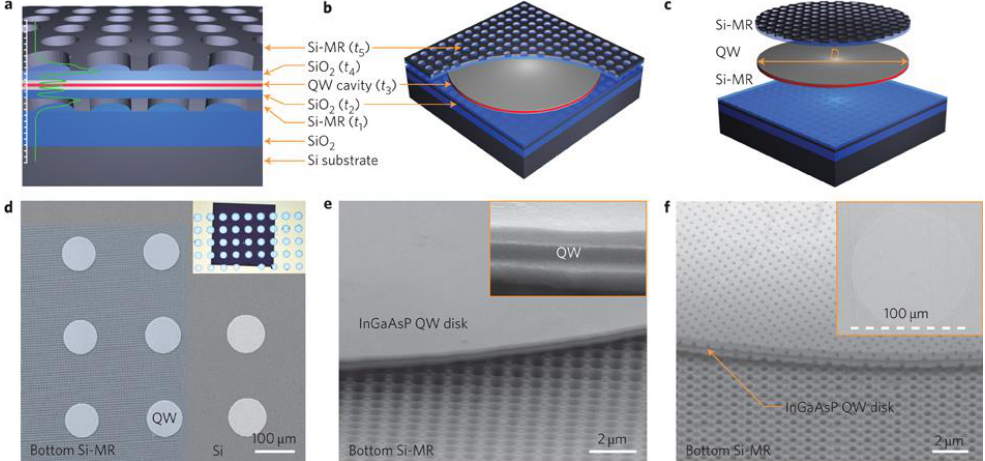
Figure 2. Vertical-cavity surface-emitting lasers (VCSEL) on silicon. ( a ) Schematic of a lasing cavity that consists of five layers (t1–t5), with a total thickness of 1–2 wavelengths. An InGaAsP quantum well (QW) is sandwiched between two single-layer Si-MRs. Also shown is a simulated electrical field distribution in the cavity for a lasing mode at 1527 nm, with a confinement factor of 6%. ( b ) A cutout view of the complete MR-VCSEL. ( c ) Illustration of the multilayer printing process for the formation of an MR-VCSEL (top Si-MR/quantum well/bottom Si-MR). The diameter of the active area is D. ( d ) SEM image of InGaAsP quantum well disks/mesas transferred onto a bottom Si-MR. Inset: optical image, showing a central dark region representing the 1 × 1 mm 2 bottom membrane reflector. ( e ) Zoom-in view of one InGaAsP quantum well disk on the bottom Si-MR. Inset: quantum well heterostructure, ( f ) SEM image of a complete MR-VCSEL, showing an InGaAsP quantum well disk sandwiched between top and bottom Si-MRs. Inset: SEM top view of an InGaAsP quantum well disk underneath a large top Si-MR layer (reprinted from [12]).